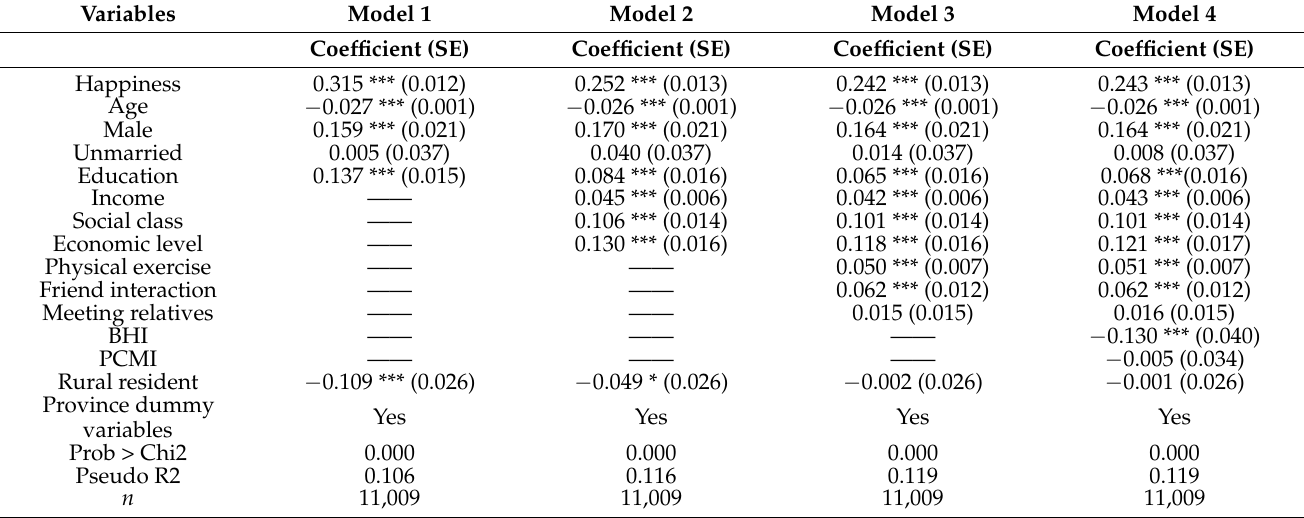
Table 3. Full sample regression results. Dependent variable: self-rated health.